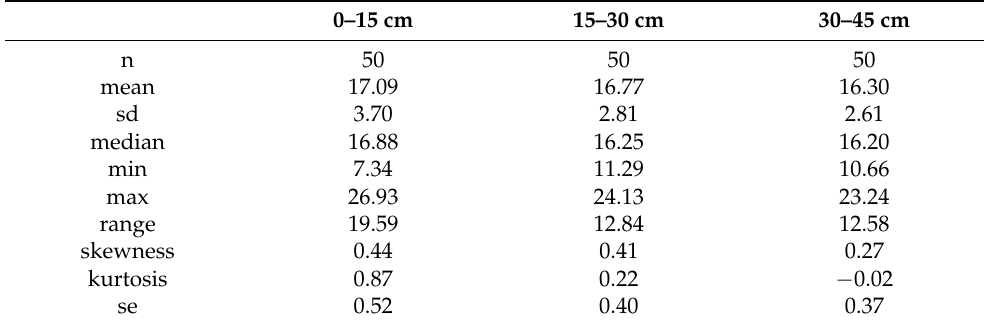
Table 1. Summary statistics of the gravimetric soil moisture (%) content of the test area for different depth intervals.